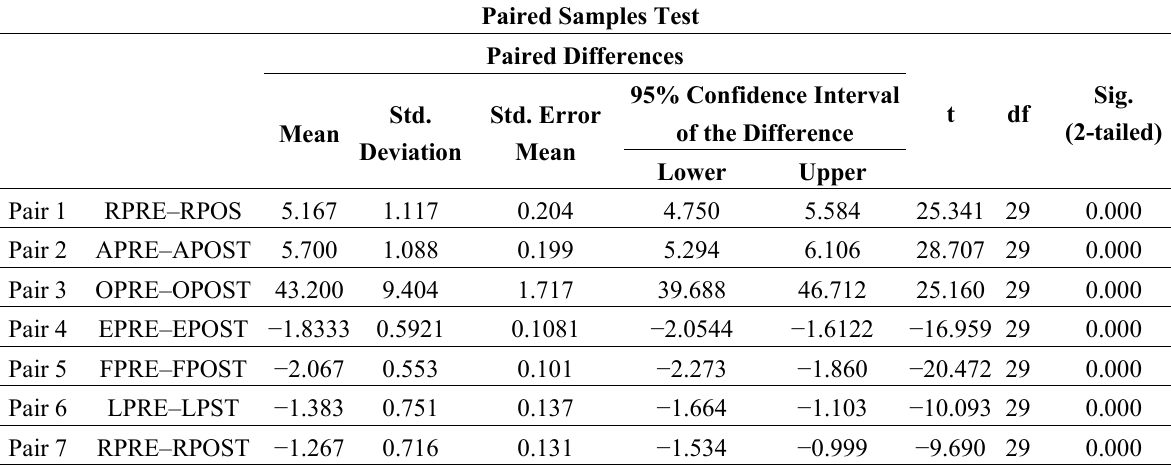
Table 3. Paired Sample Test to observer the Pre-Post intervention